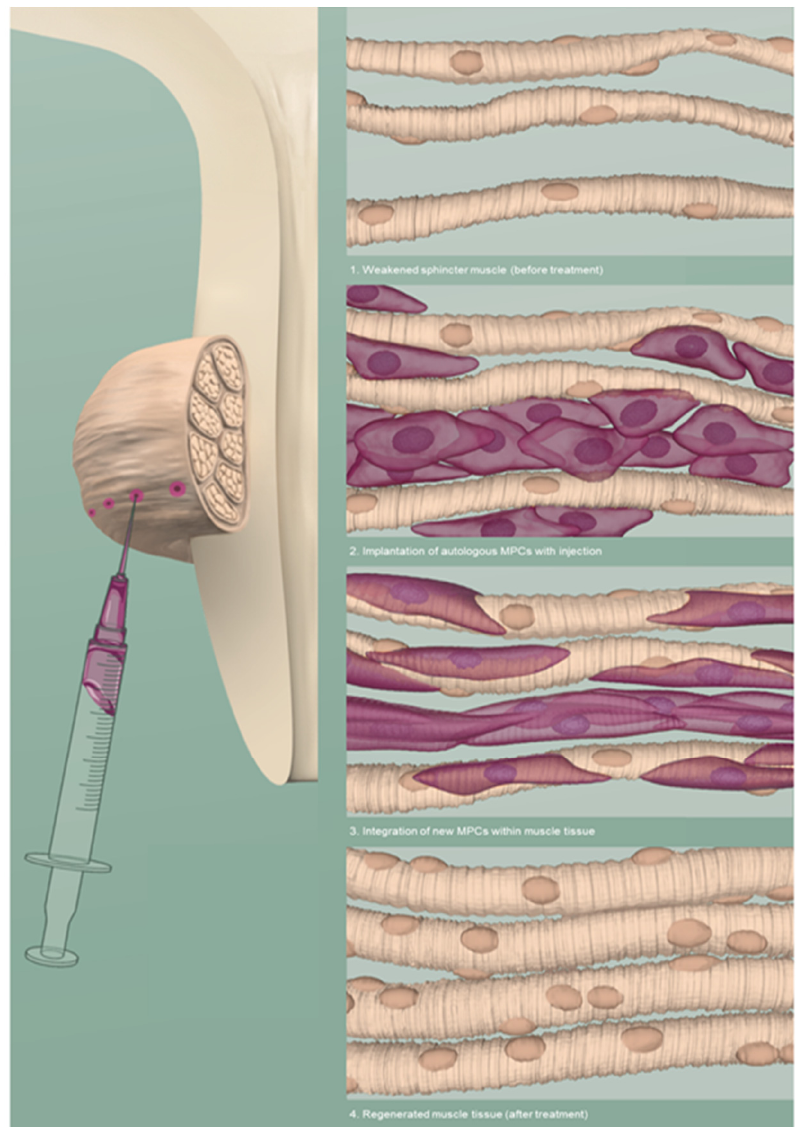
Figure 1. Schematic visualisation of an intrasphincteric injection of muscle precursor cells (MPCs) to regenerate the muscle tissue of the EUS. Adapted from © Jasmin Hegetschweiler and Nina Schwarz.